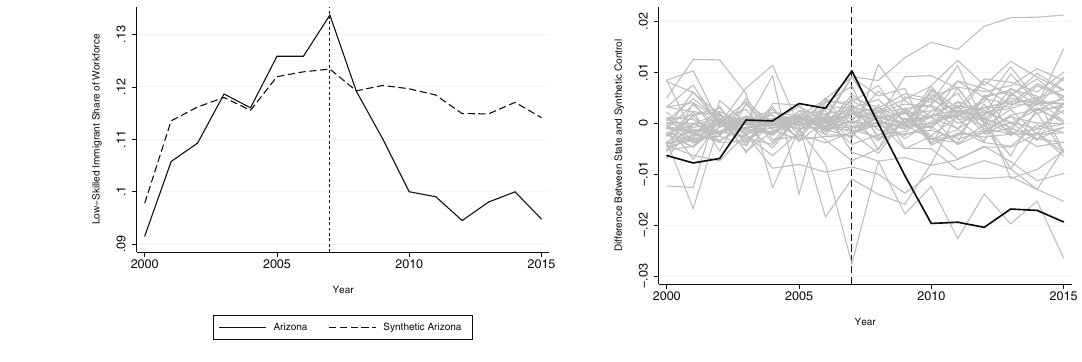
LAWA and share of low-skilled immigrants in